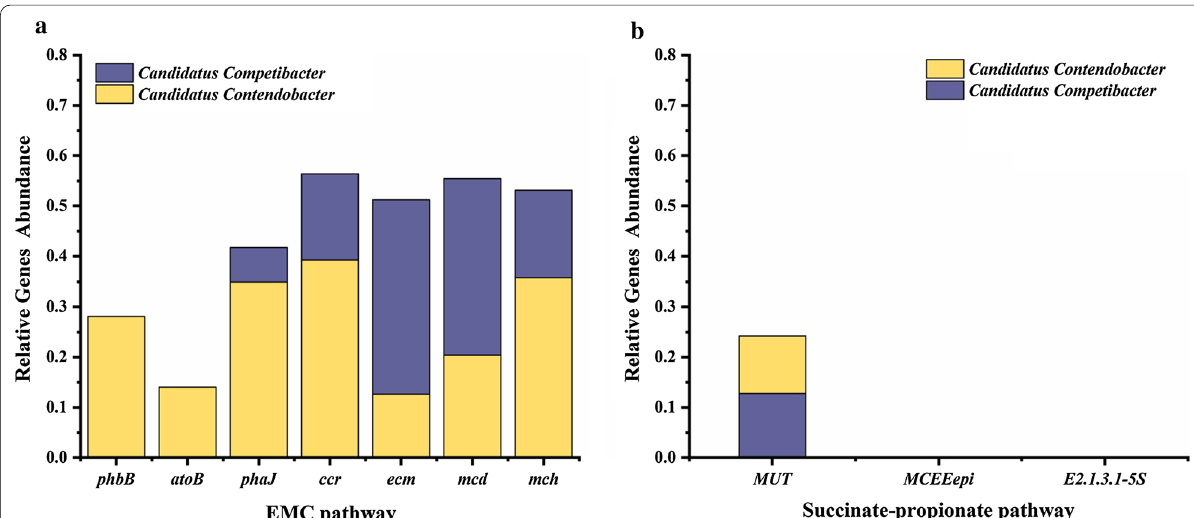
Fig. 6 The analysis of key genes in Candidatus Contendobacter and Candidatus Competibacter on day 39. a Relative abundance of key genes of the EMC pathway. b Relative abundance of key genes of succinate-propionate pathway